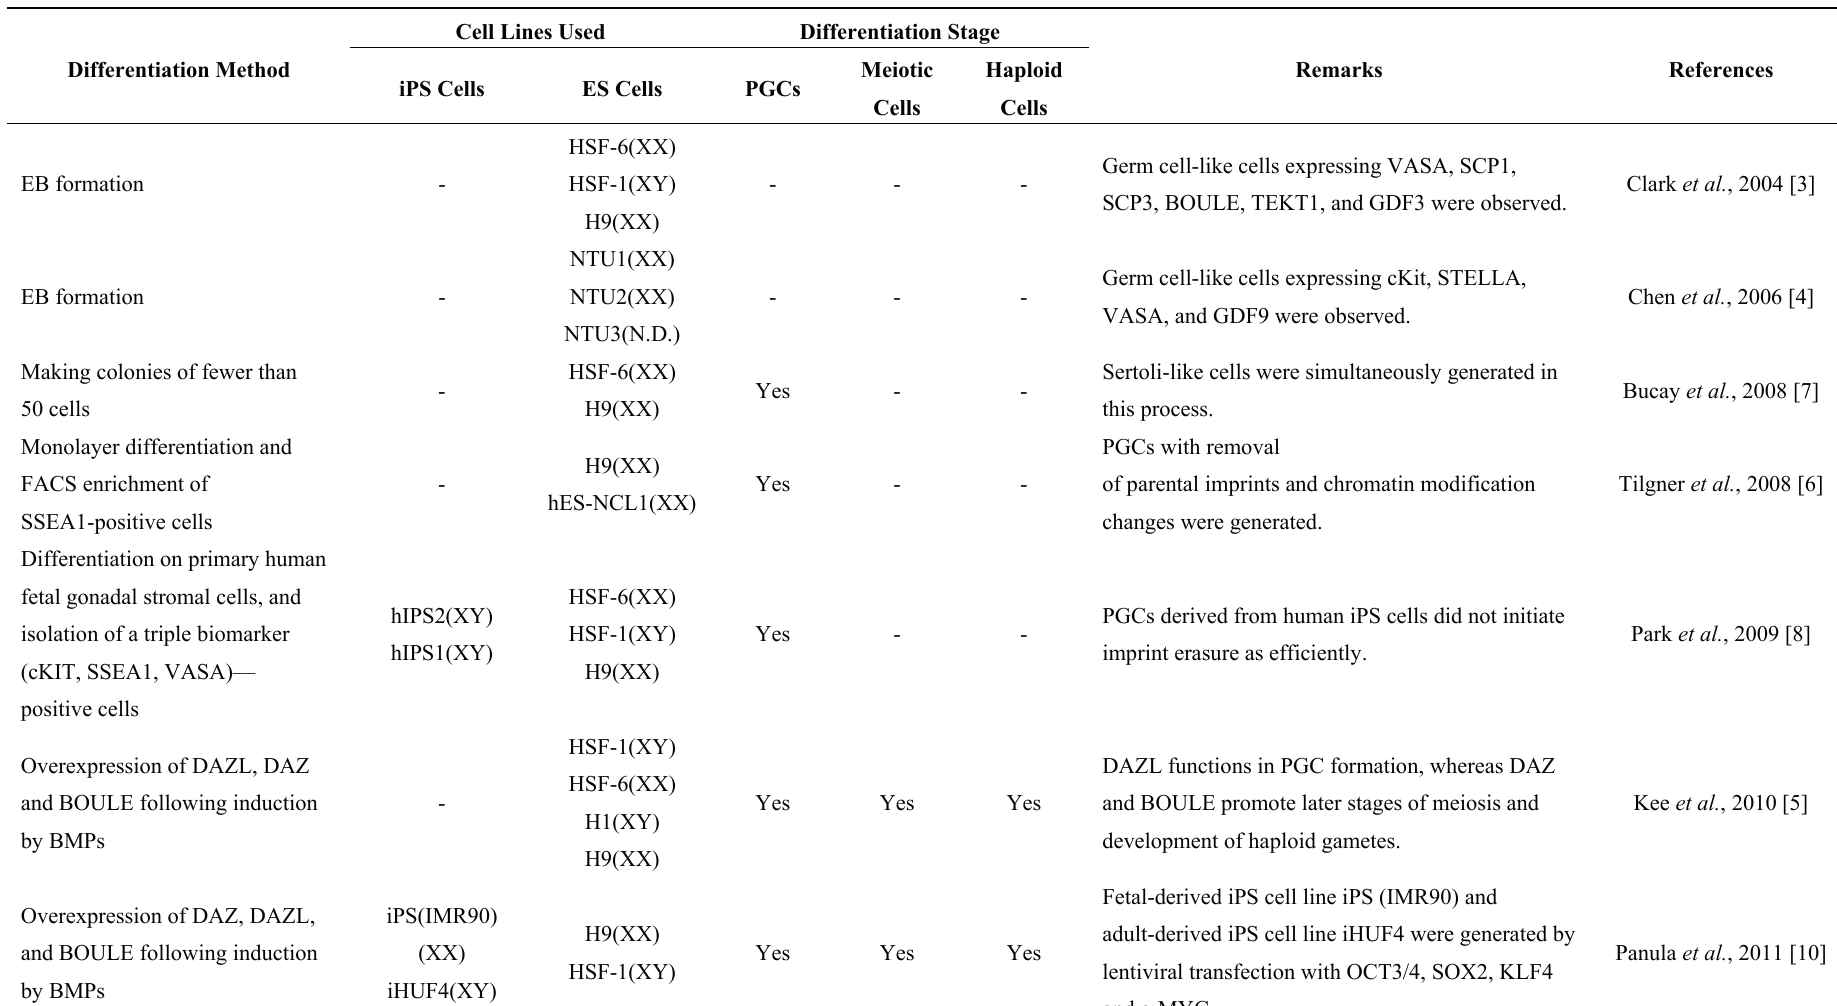
Table 1. Induction of germ cells from human pluripotent stem cells in vitro or in vivo